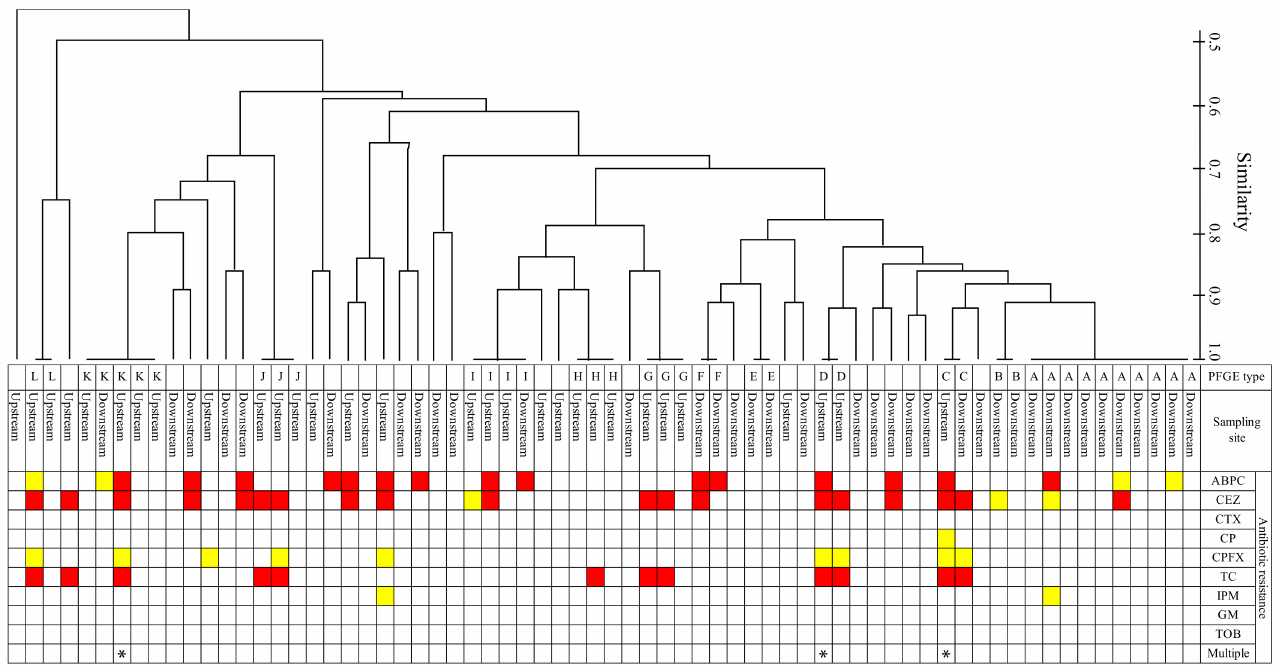
Figure 3. Dendrograms of pulsed-field gel electrophoresis types and antibiotic resistance profiles for E. coli isolates from each sampling site in the Kaeda River. Concerning antibiotic resistance phenotypes: red indicates resistance, yellow indicates intermediate resistance, and white indicates susceptibility. Ampicillin, ABPC; cefazolin, CEZ; cefotaxime CTX; chloramphenicol, CP; ciprofloxacin, CPFX; tetracycline, TC; imipenem, IPM; gentamicin, GM; tobramycin,